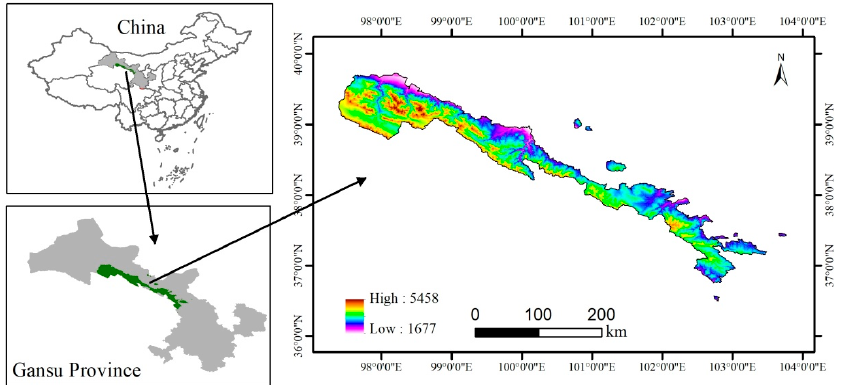
Figure 1. Location of the study area in Gansu Province, China, and its digital elevation model (DEM).